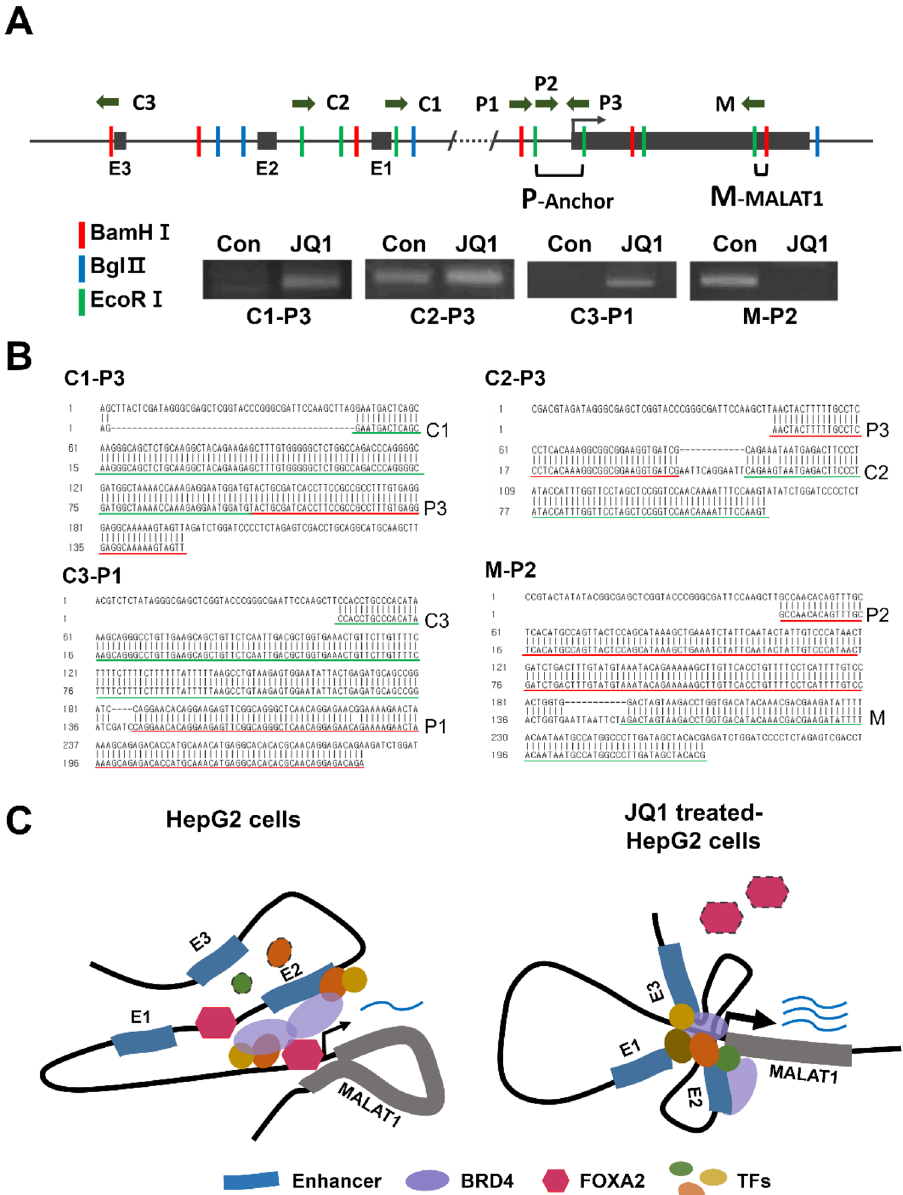
Figure 5. JQ1 reconfigures the MALAT1 gene locus. ( A ) 3C analysis of MALAT1 gene locus in JQ1-treated and control HepG2 cells. Top, diagram of the MALAT1 gene locus showing the restriction enzyme sites used for 3C. Bottom, PCR results of 3C experiment. E1, E2, E3, putative enhancers; M, P1, P2, P3, C1, C2, C3, primers. ( B ) Sequencing of the MALAT1 enhancer and promoter intrachromosomal loop products. Green and red lines indicate the sequences of each fragment marked on the right. ( C ) Schematic interpreting the 3C analysis. In untreated HepG2 cells (left), the E2 enhancer and FOXA2 and BRD4 are key components of the promoter- associated chromatin complex, in contrast with E1 and E3. In JQ1-treated HepG2 cells (right), the reconfigured chromatin complex also involves E1 and E3 but loses FOXA2 and a significant portion of the BRD4. These changes result in an increased expression of MALAT1